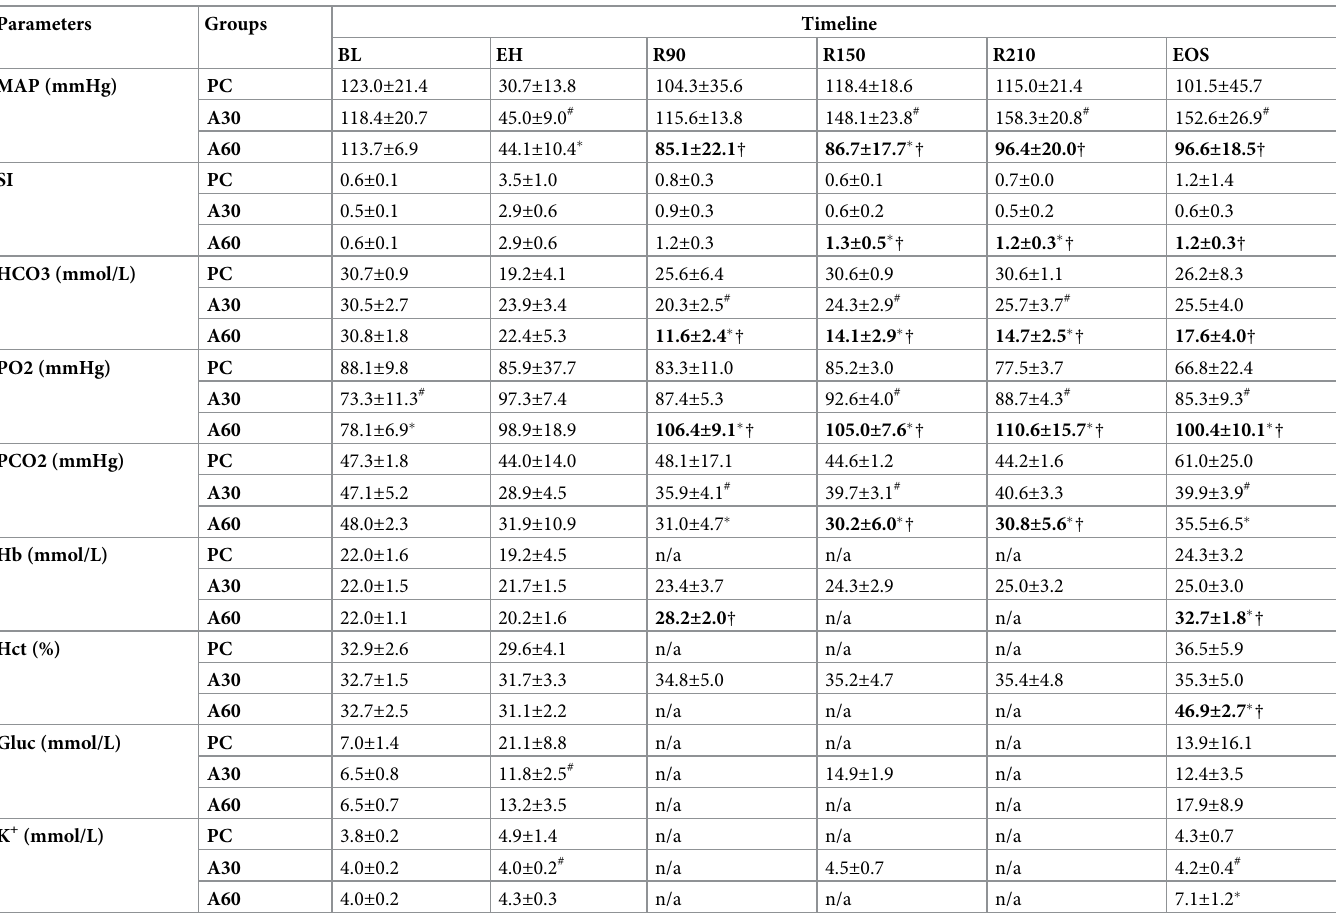
Table 1. Hemodynamics and metabolic characteristics in swine. Parameters